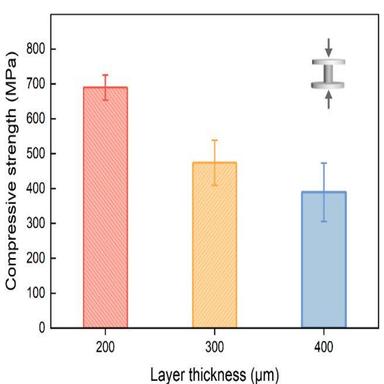
Comparison of compressive strength of the 3D-printed zirconia specimens under different layer thicknesses.